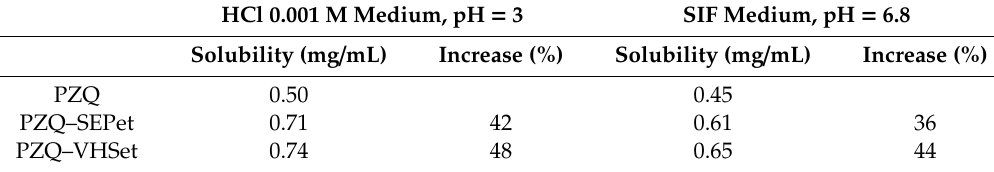
Table 1. Solubility values (in mg / mL) of praziquantel (PZQ), PZQ–SEPet and PZQ–VHSet and increase solubility (in %) with respect to that of PZQ in acid and SIF media (solubility mean values ± 0.07 SD; n =